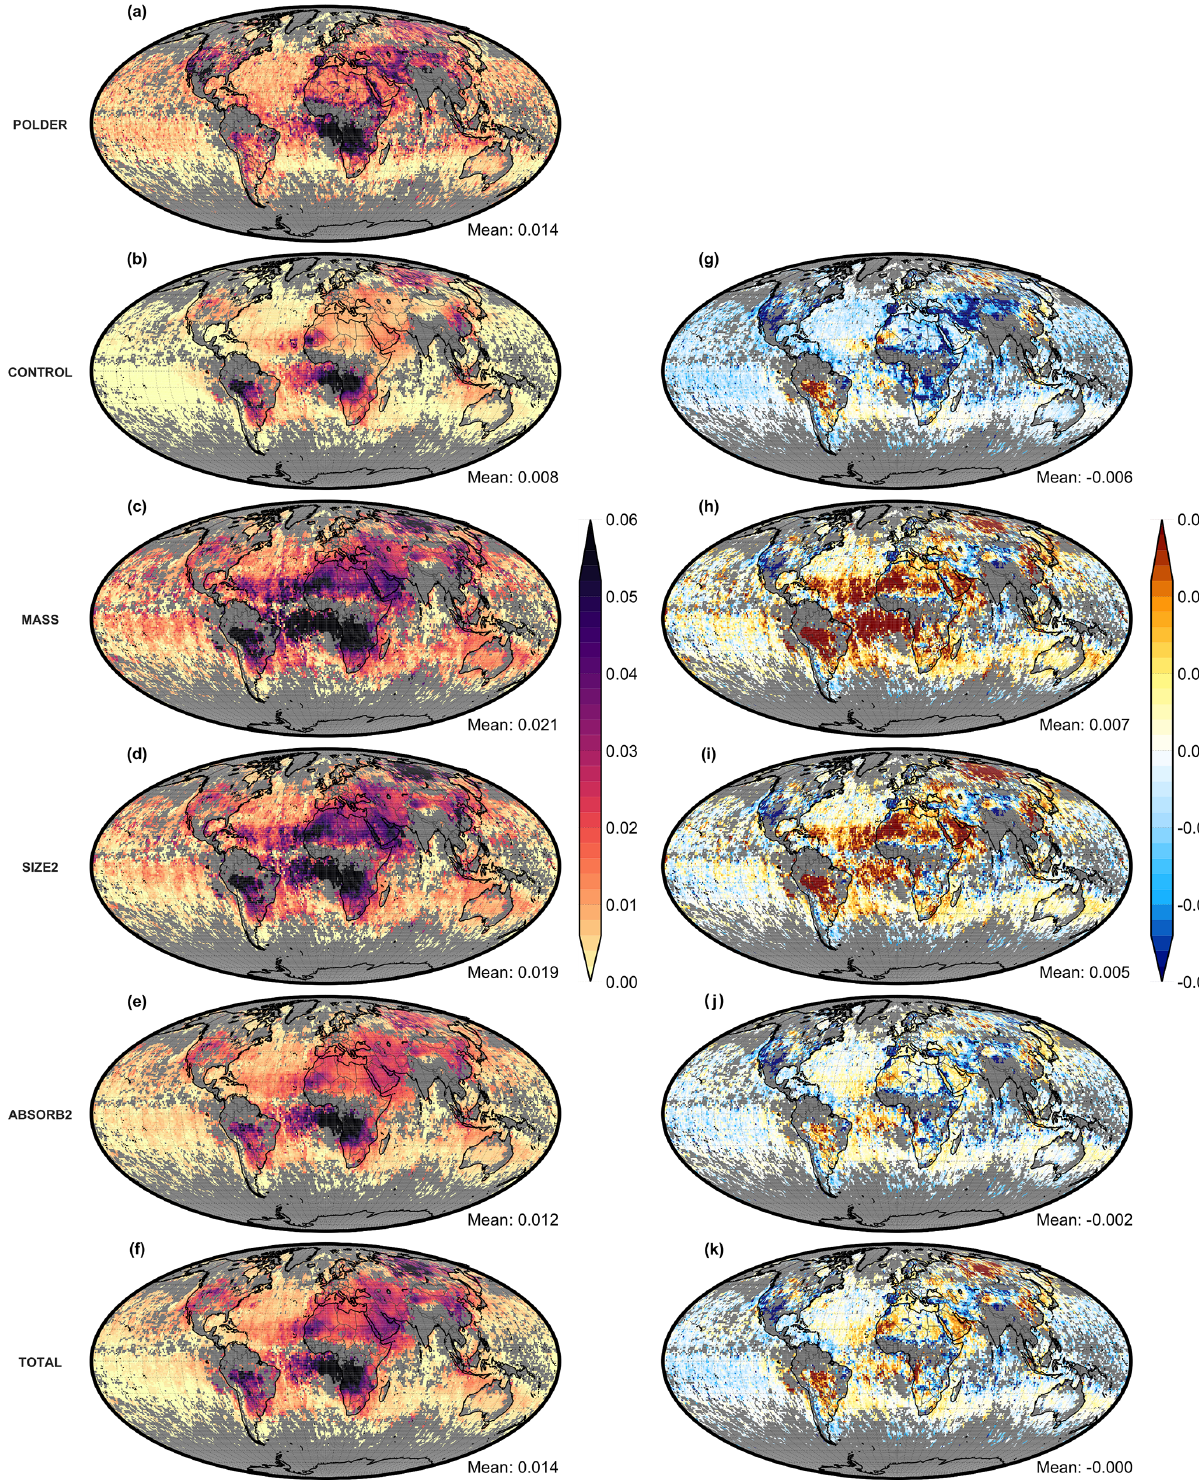
Figure 9. Similar to Fig. 5 but for absorption optical depth at